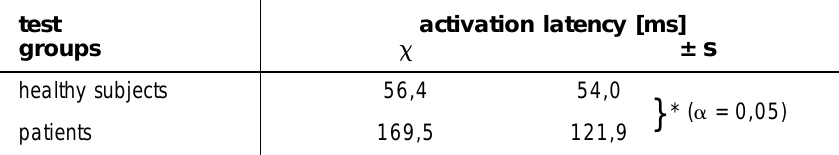
Table 3: Mean activation latencies in anteversion of the arm.